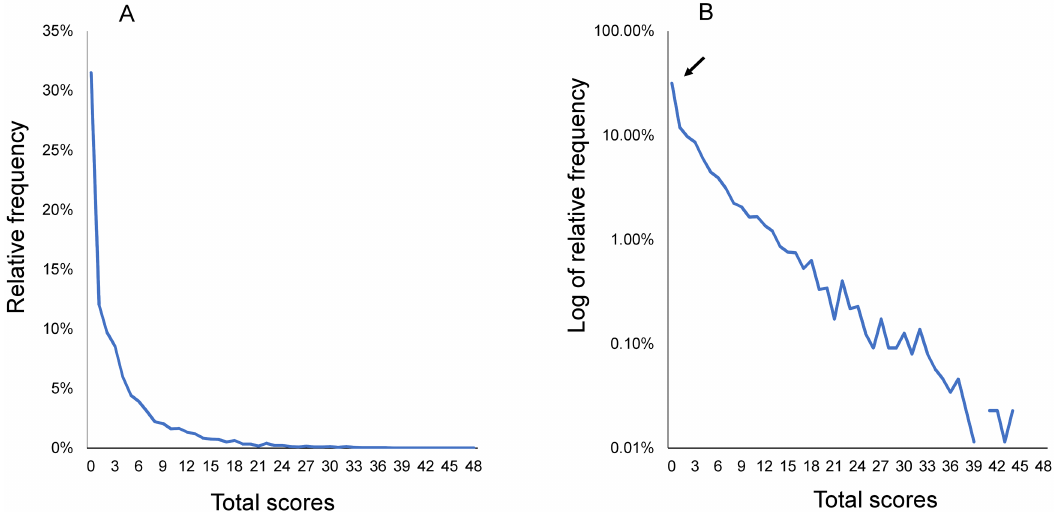
Fig 5. Total score distribution of the 16 items on normal and log-normal scales. Total score distribution of the 16 items along a normal scale (A) and a log-normal scale (B). (A) The total score distribution of the 16 items was right-skewed. (B) The total score distribution for the 16 items followed an exponential pattern (linear pattern), except for at the lower end of the distribution. The distribution at the lower end (arrow) exhibited higher frequencies compared to those expected for an exponential